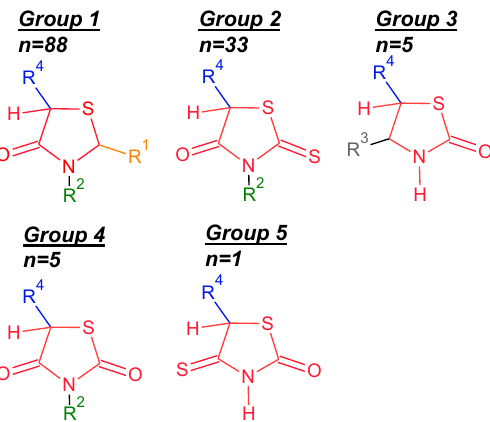
Figure 3. The general structure of five groups of 4-thiazolidinone derivatives with particular frag- ments marked different colors: common cores ( Φ )—red, and substituents R1—orange, R2—green, R3—gray, R4—blue.